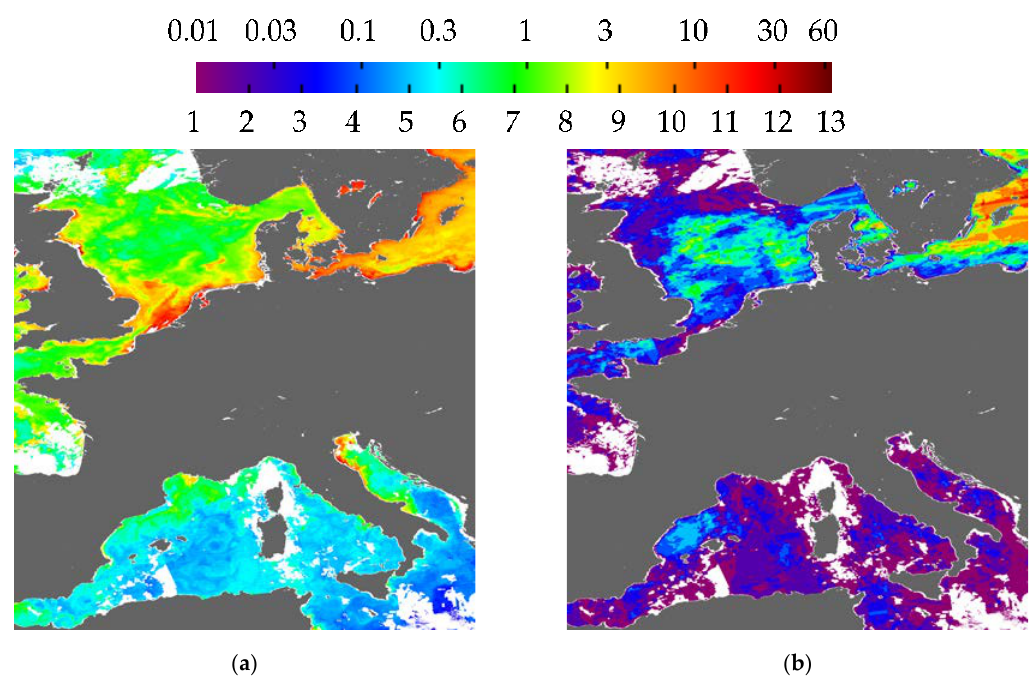
Figure 6. ( a ) Unweighted composite of chl from 1 to 8 May 2013 using the mean of ln(chl), shown at the top of the scale bar in mg m −3 ; ( b ) number of chl values contributing to each pixel, shown at the bottom of the scale bar.